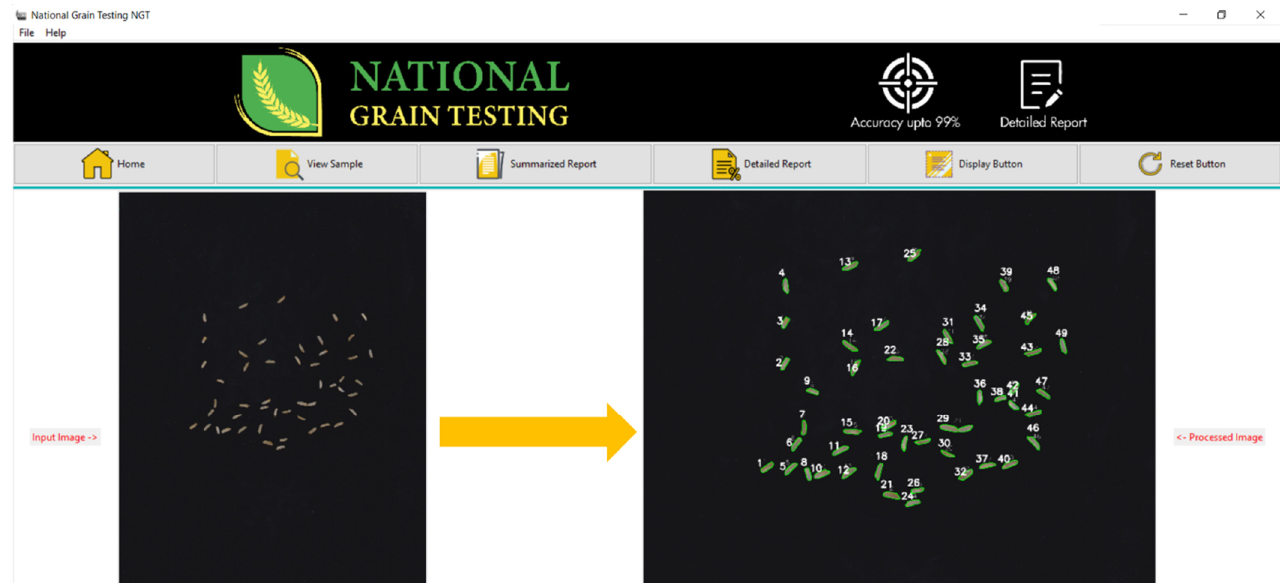
Figure 7. Computes the size (length and width) of rice kernel.